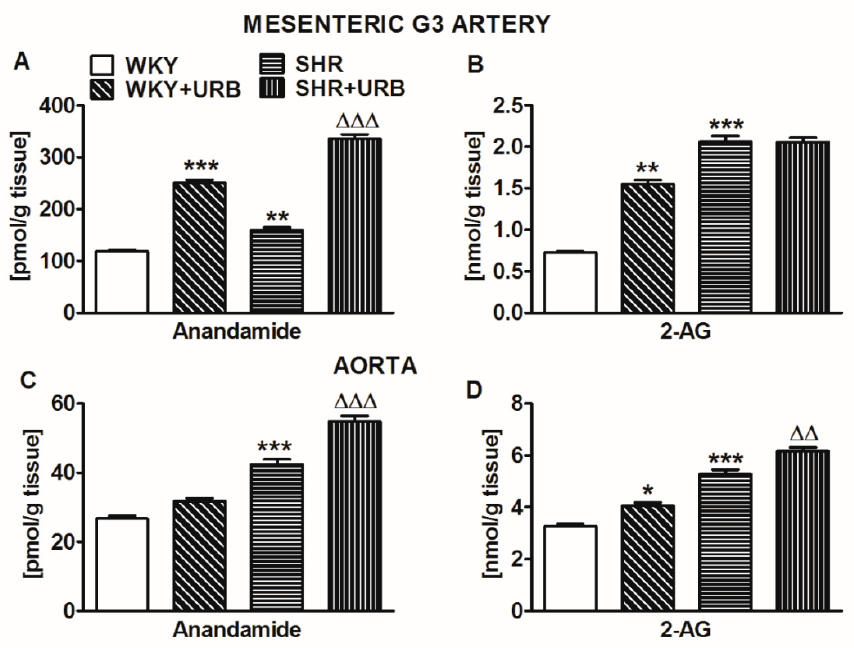
Figure 7. Concentrations of anandamide ( A , C ) and 2-arachidonoylglycerol (2-AG; B , D ) in the mesenteric G3 arteries ( A , B ) and aortas ( C , D ) of normotensive rats—control (WKY) and URB597- treated (WKY + URB)—or hypertensive rats—SHR and URB597-treated (SHR + URB). URB597 at 1 mg/kg or its vehicle was injected intraperitoneally every 12 h for 14 days. Data are presented as mean ± SEM ( n = 6 per group); * p < 0.05, ** , ∆∆ p < 0.01, and *** , ∆∆∆ p < 0.001 compared to the respective control groups (* WKY or ∆ SHR).